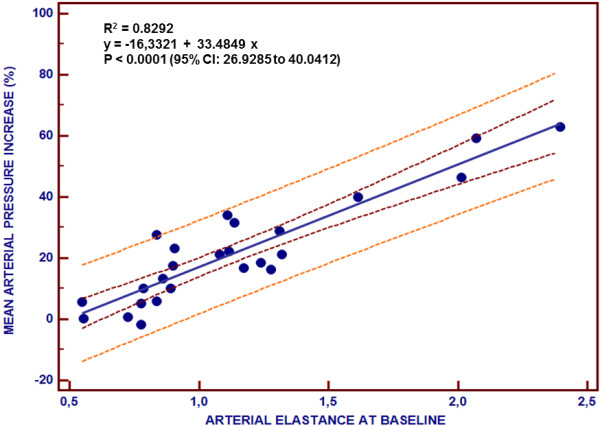
Dynamic arterial elastance and mean arterial pressure change relationship. Linear regression analysis of the relationship between baseline dynamic arterial elastance and changes in mean arterial pressure after volume administration are shown. Dashed lines represent 95% confidence intervals for the regression line (solid line).